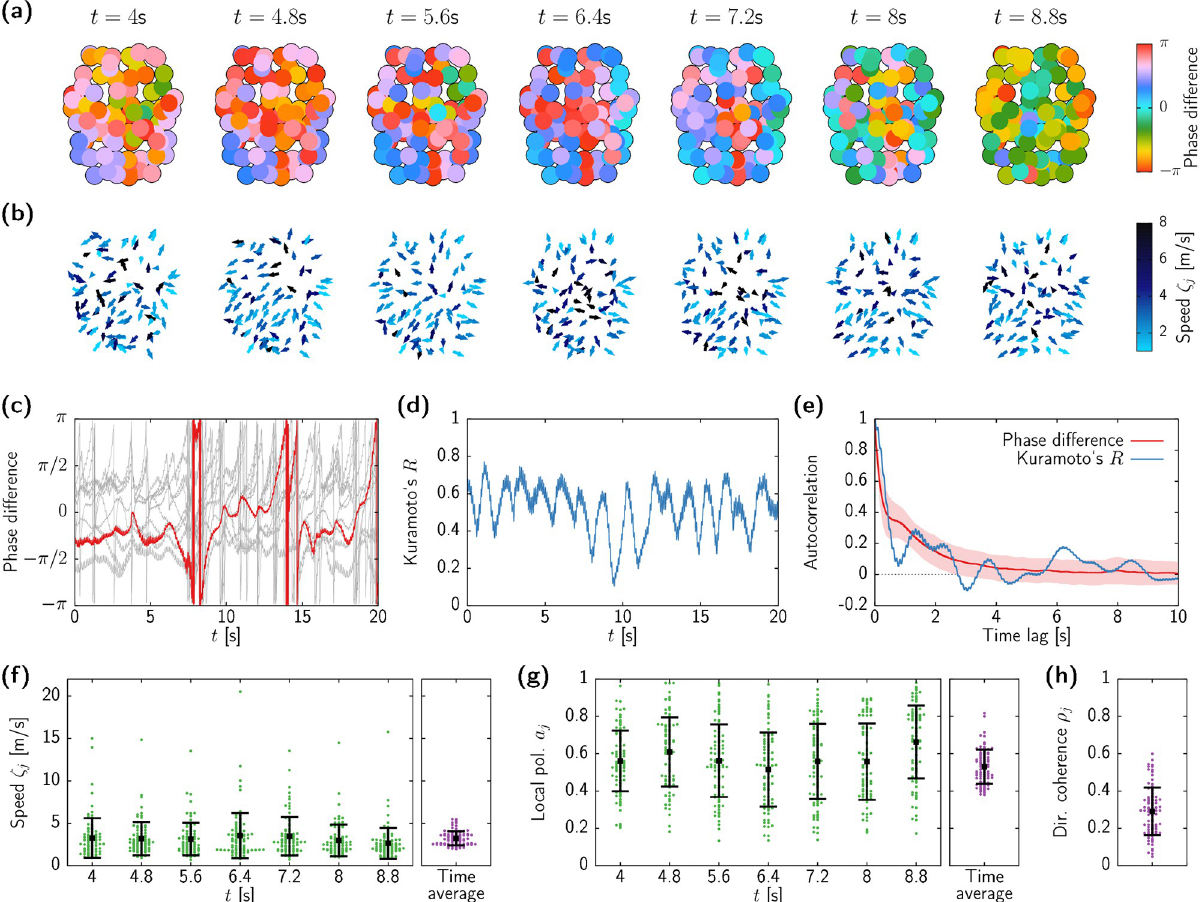
Fig 4. Spatiotemporal dynamics of the chaotic state. (a) Snapshots of the phase differences ϕ C between each node’s phase and the collective phase j − for a simulation with p = 170, � = 20. (b) Snapshots of the propagation directions colored according to the corresponding speed. (c) Time series of the phase difference ϕ j − C for 10 nodes (grey curves), with an individual brain region highlighted with a red thick line. (d) Time evolution of the Kuramoto order parameter R . (e) Autocorrelation of R (blue curve) and average correlation of the phase differences (red curve), with the corresponding standard deviation shown as a light red shadow. (f-h) Swarm plot of instantaneous propagation speeds z j (f), local polarization a j (g), and directional (h), corresponding to the snapshots in (a). Circles show the values of individual brain regions, black squares indicate average value, and coherence ρ j error bars show standard deviation.